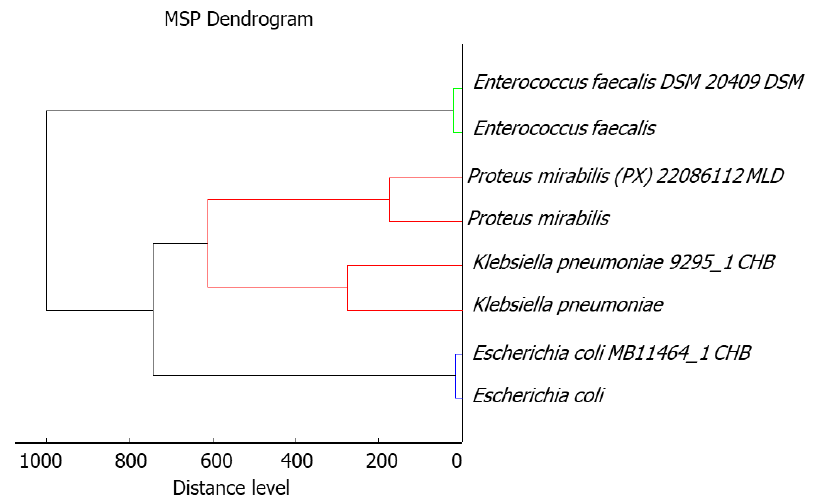
Figure 1. Phyloproteomic tree of the isolated bacterial strains, identified by MALDI Biotyper Com- pass platform.